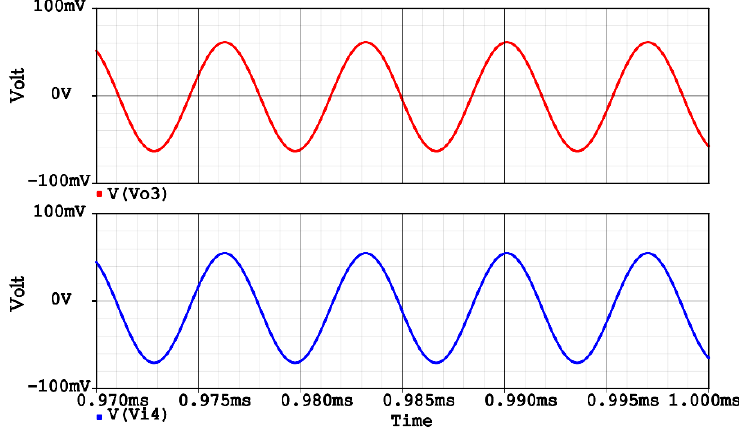
Figure 17. Simulated time-domain voltage input (blue line) and voltage output (red line) signals of BP filter.